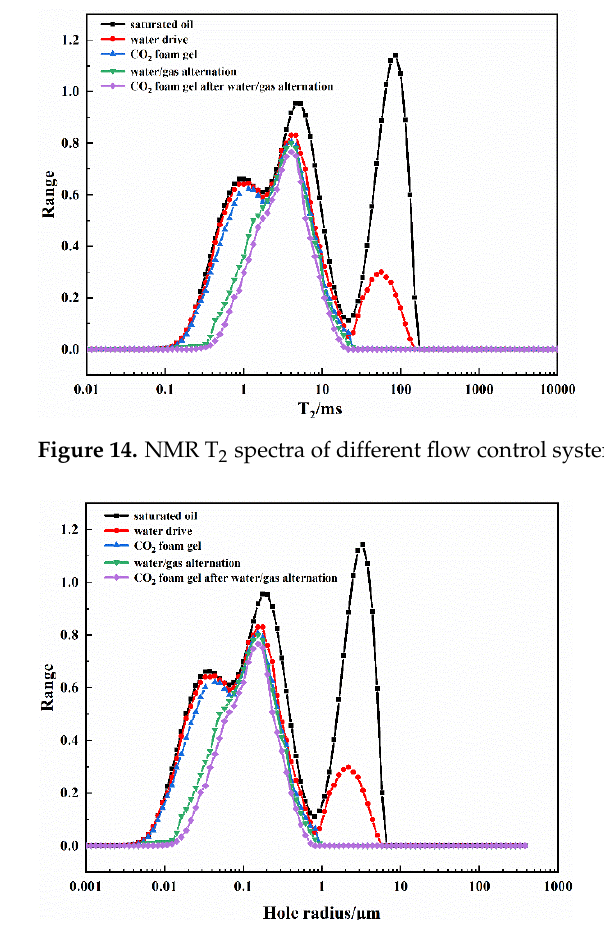
Figure 15. Pore throat radius distribution of different flow control systems in core No. 6.